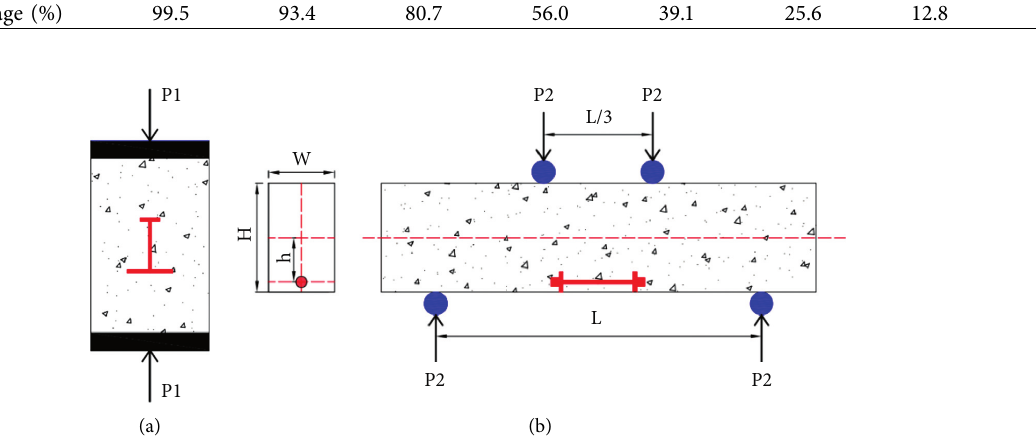
Figure 2: Schematic diagram of the testing. (a) The uniaxial-compression test; (b) the four-point bending test.